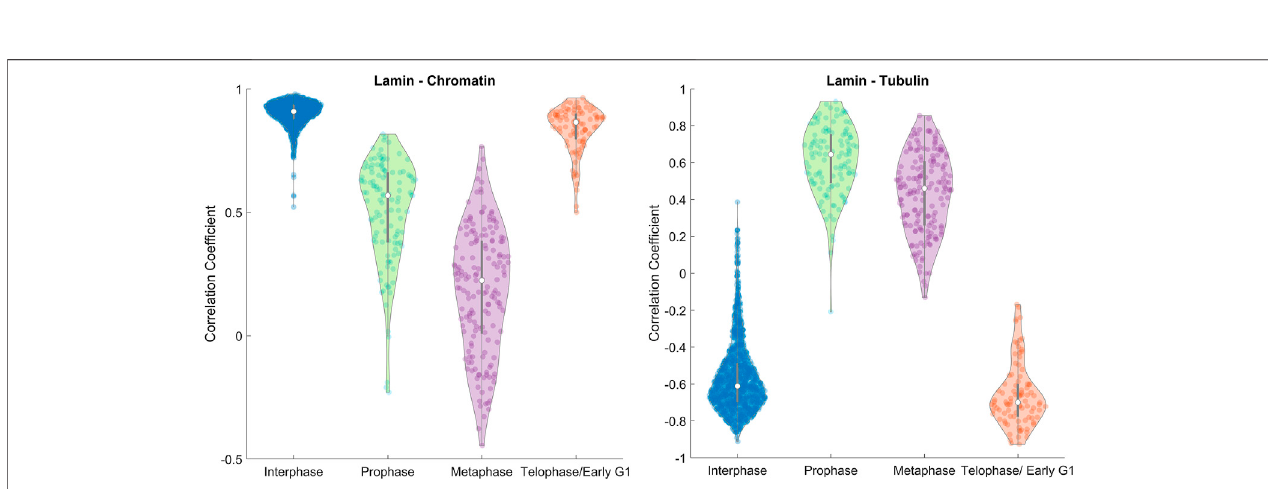
FIGURE 3 | Image correlation. The distributions of the spatial correlation coef fi cient between lamin A – chromatin (Left) and lamin A – tubulin (Right) shown in violin plots(Bechtold,2016)calculatedforallthemeasured MEFcells. Theviolinplotshows thedistributionofthecorrelationcoef fi cientfordifferentphases, themedian (white circle), and interquartile ranges (thick gray bar). Data were derived from ∼ 1200 MEF cells in interphase, ∼ 100 – 170 MEF cells in each phase of